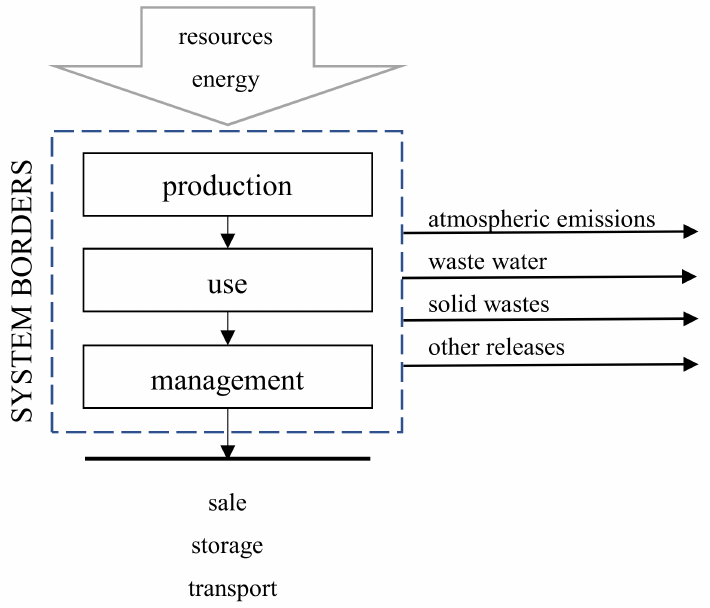
Figure 3. Scope of the LCA analysis of the turbine in a 25-year lifecycle and the same turbine after